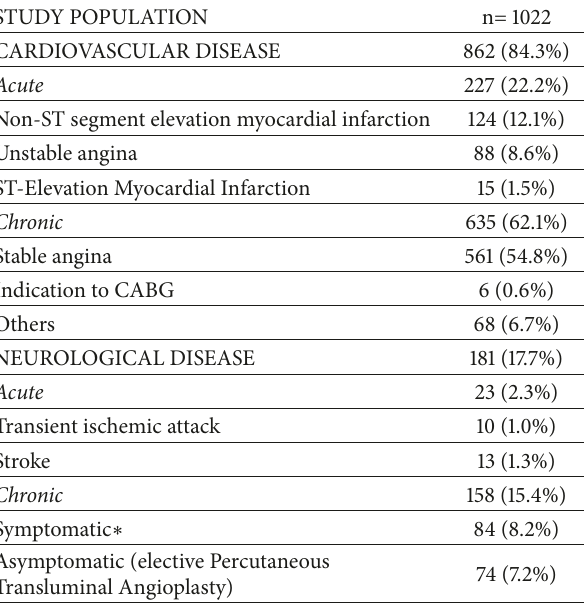
Table 1: Clinical diagnosis at